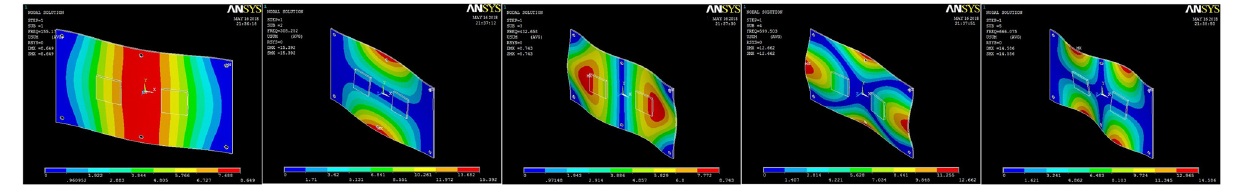
Fig. 12. Mode shapes of the corresponding modes.